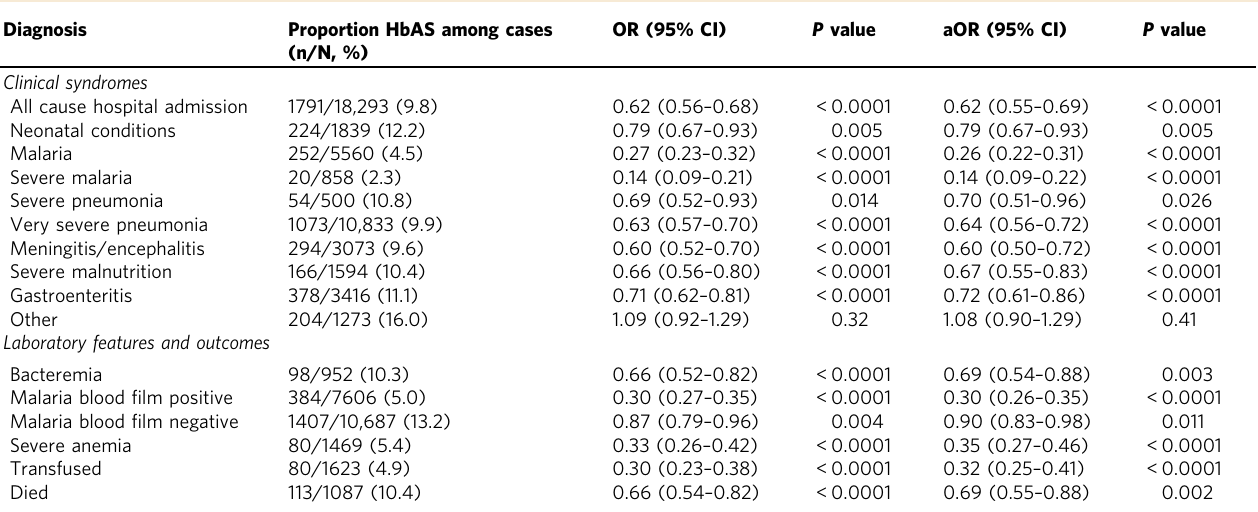
Table 3 The odds ratios for HbAS in case-patients versus community controls Diagnosis Proportion HbAS among cases OR (95% (n/N, %)